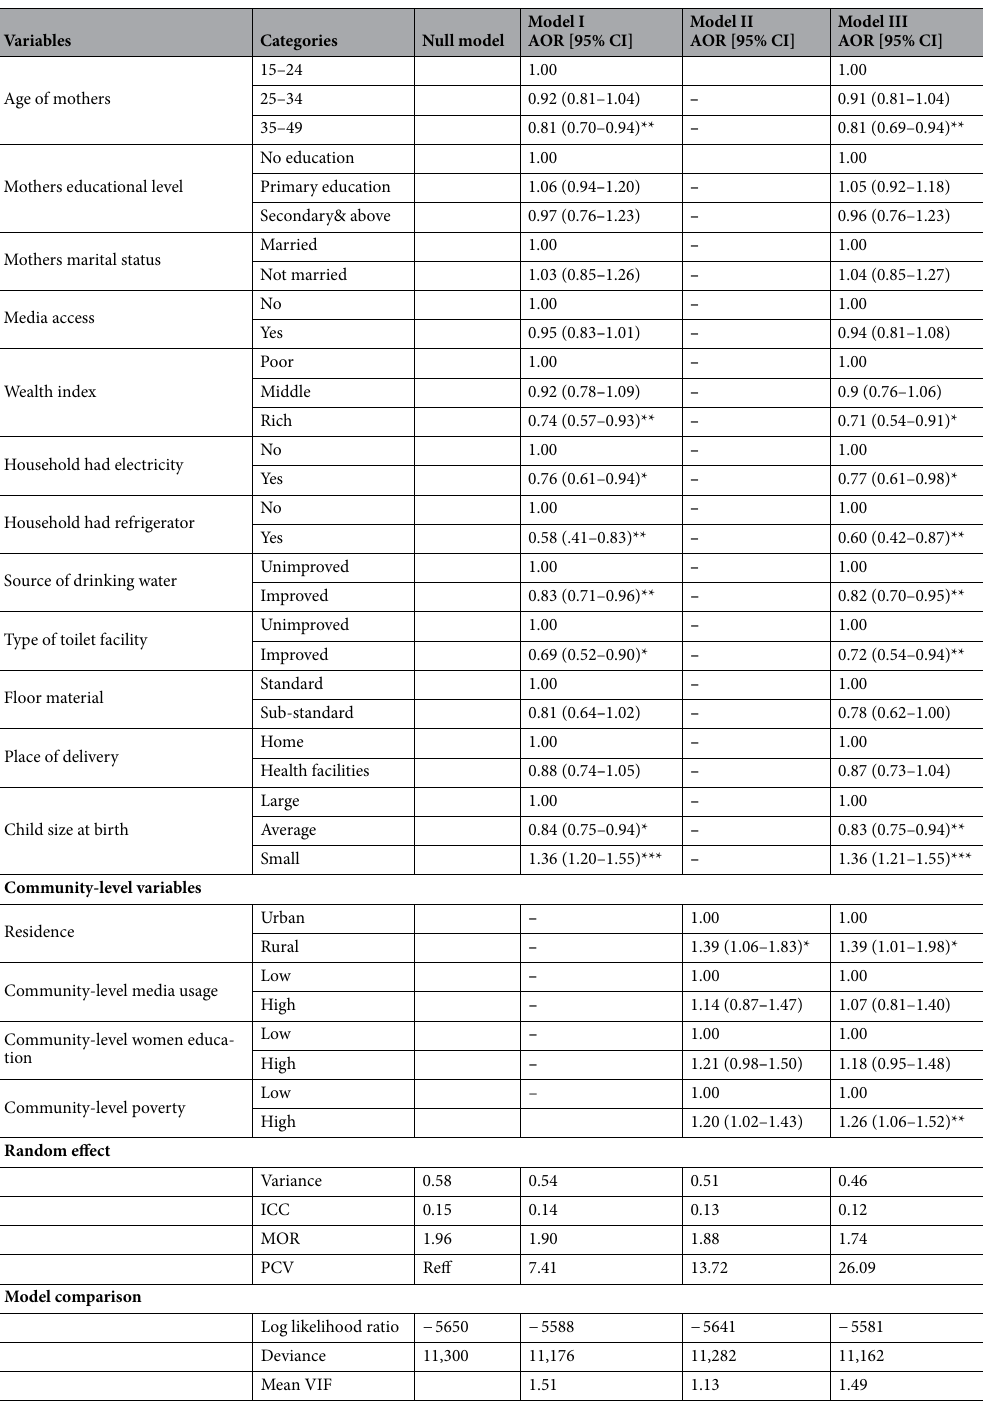
Table 3. Multivariable multilevel logistic regression analysis results of both individual-level and community-level factors associated with common childhood illness in Ethiopia, EDHS 2016. * P -value < 0.05, ** P -value < 0.01, *** P -value < 0.001. ICC Inter cluster correlation coefficient, MOR Median odds ratio, PCV Proportional change in variance, AOR Adjusted odds ratio, CI Confidence interval, VIF Variance inflation